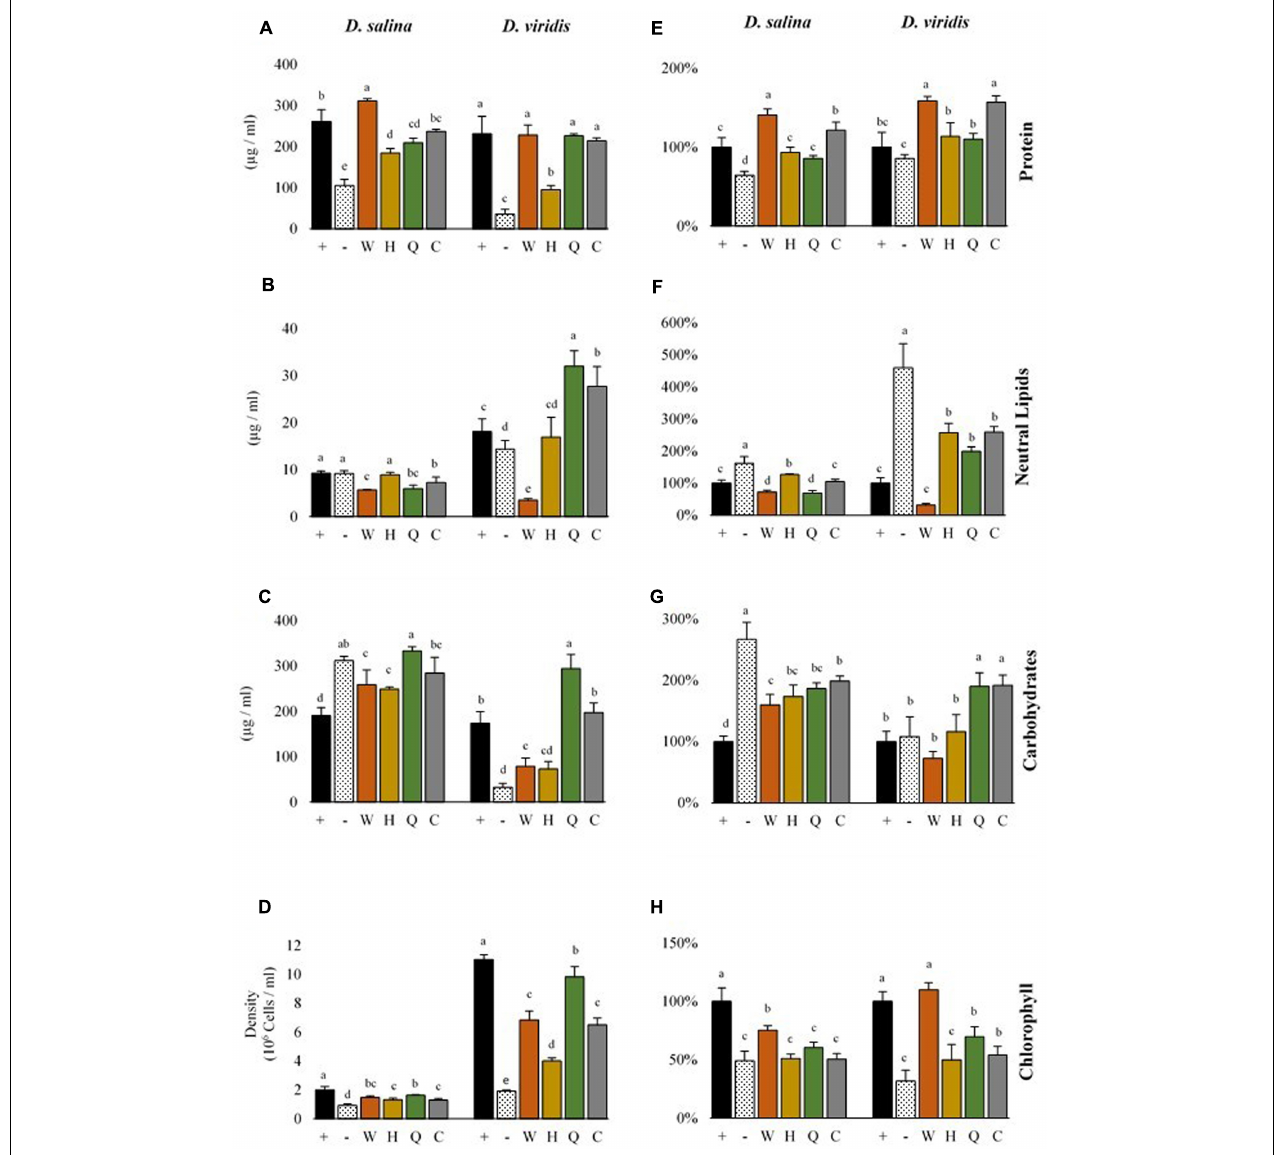
FIGURE 4 | Metabolite productivity and content of D. salina and D. viridis. Abbreviations: + (mBA), - (mBA -N), W (tryptophan), H (histidine), Q (glutamine), C (cysteine). Volumetric productivity (left column) of soluble protein (A) , neutral lipids (B) , total carbohydrates (C) , and cell density (D) of cultures grown for 144 h. The cell content of soluble protein (E) , neutral lipids (F) , total carbohydrates (G) , and chlorophyll (H) is expressed relative to KNO − 3 supplemented cultures (mBA), which are used as a reference (100%). Error bars represent one standard deviation. Statistically significant population groupings are indicated (a,b,c,d,e; Tukey’s HSD; α ≤ 0.05). Four biological replicates were used for